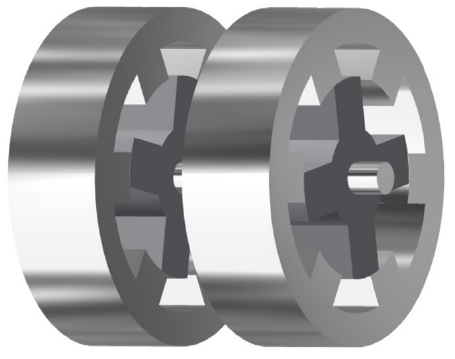
Figure 10. A two-stack conventional switched reluctance motor [112].